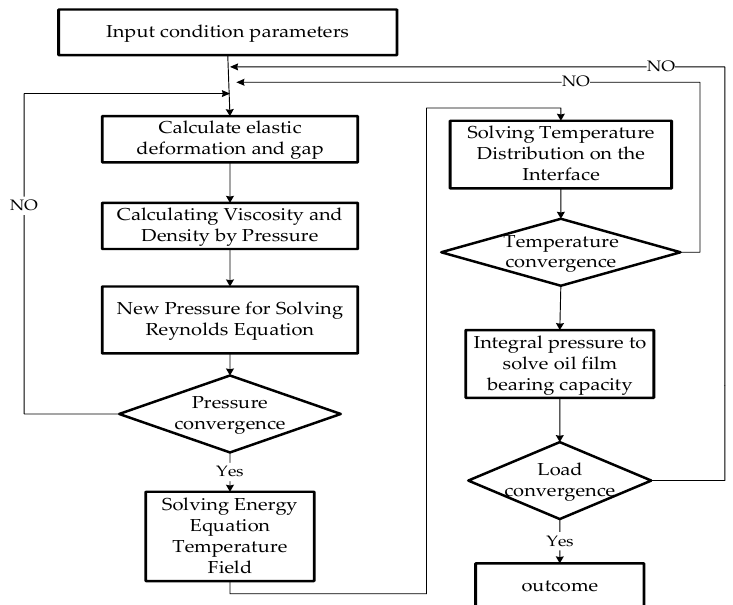
Figure 1. Thermal EHL numerical analysis process .